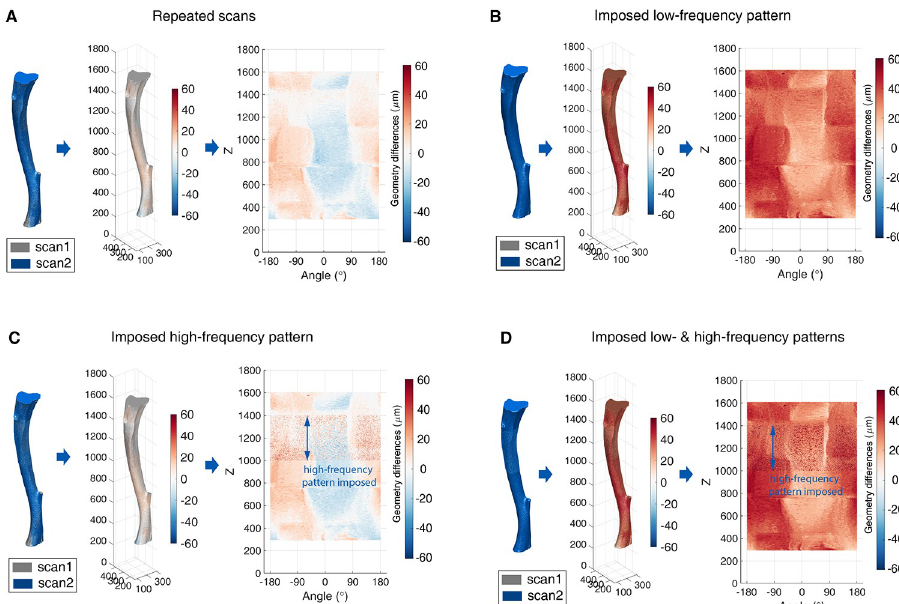
Fig 2. Prepared data for the algorithmic accuracy analysis. (A) Scenario 1: zero low- and high-spatial frequency activity; (B) Scenario 2: only imposed low-spatial frequency activity; (C) Scenario 3: only imposed high-spatial frequency activity; (D) Scenario 4: imposed low- and high-spatial frequency activity; In each figure, from left to right, they correspond to the geometry of periosteum at the first and the second scan at different scenario, the corresponding geometric changes and the unwrapped geometry change maps, respectively. The colourmap is used to indicate the magnitude and direction of the geometry difference, i.e., the warm colour (positive value) corresponds to the outward- pointing normal direction of the bone surface while the cold colour (negative value) corresponds to the inward- pointing normal direction.